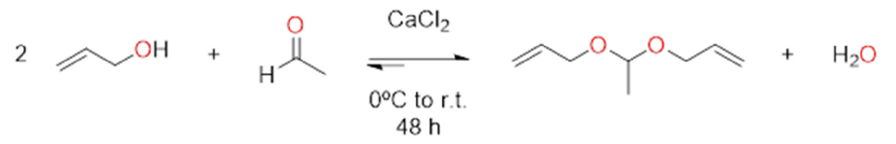
Figure 2. 1 H ‐ NMR of acetaldehyde diallylacetal (B monomer) at 300 MHz in CDCl 3 .